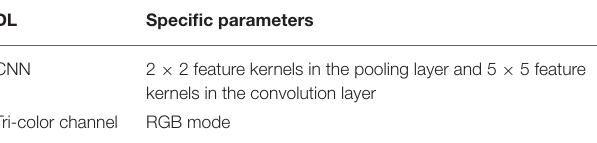
TABLE 1 | DL parameter